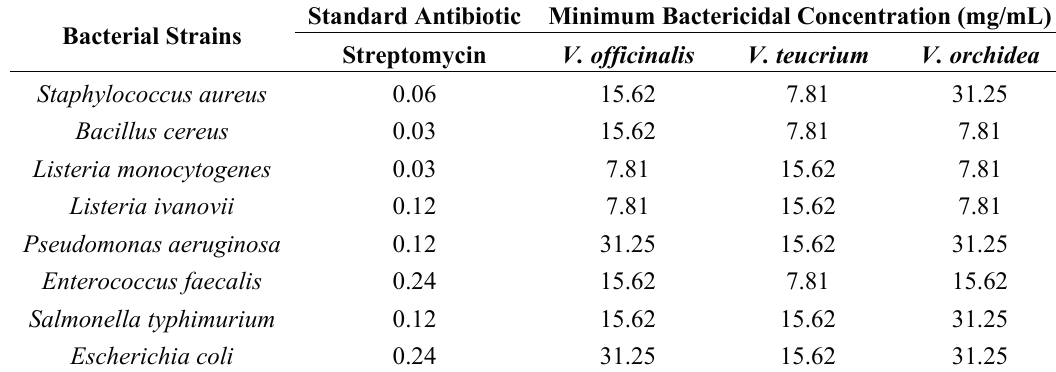
Table 7. Minimum bactericidal concentration (MBC) of V. officinalis , V. teucrium and V. orchidea extracts and streptomycin against bacterial strains tested by microdilution method. Bacterial